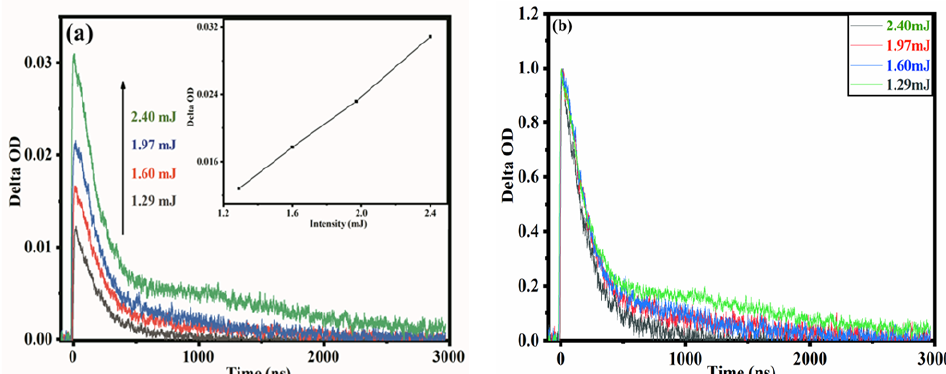
Figure 3. Temporal profiles of transient absorption spectrum on LaMn 0.6 Ni 0.4 O 3 observed at 480, 520 and 800 nm suspended in CH 3 OH.